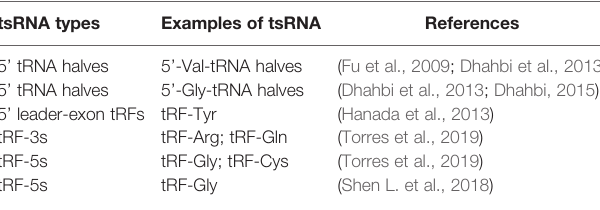
TABLE 2 | Summary of transfer RNA-derived small RNAs (tsRNAs) expressed in cardiac